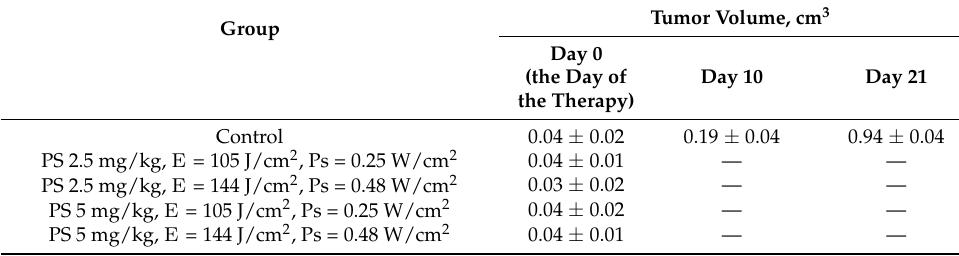
Table 1. Antitumor Efficacy of PDT (M ±